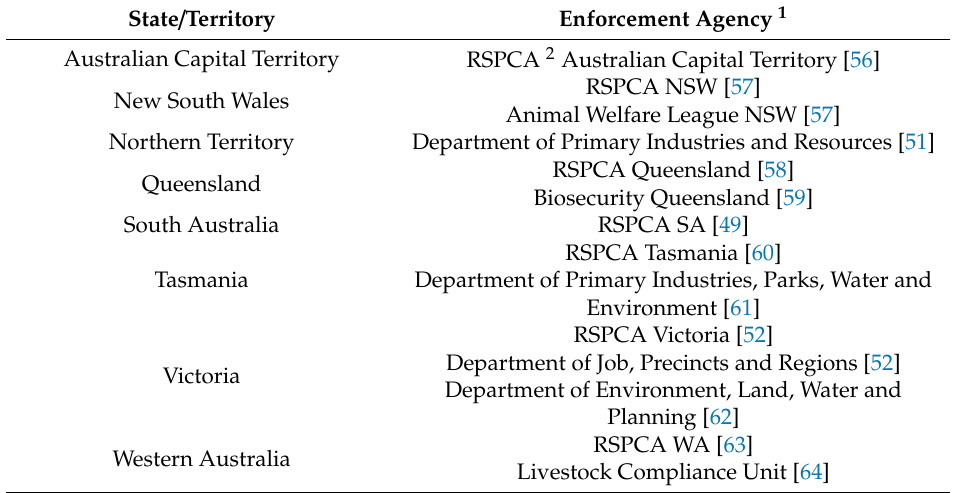
Table 2. Each state and territories’ relevant animal welfare legislation and predominant enforcement agencies in